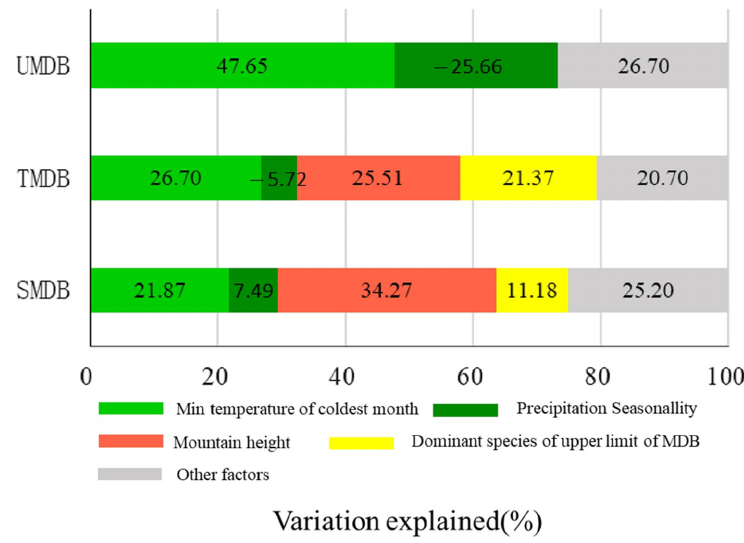
Figure 9. The relative contribution of environmental factors to the geographical pattern of the upper limit of montane deciduous broad-leaved forest in the east realm of China. UMDB, the upper limit of deciduous broad-leaved forest on the mountains with climatic treeline; TMDB, the upper limit of deciduous broad-leaved forest on the temperate mountains without climatic treeline; SMDB, the upper limit of deciduous broad-leaved forest on the subtropical mountains without climatic treeline. “ − ” in front of a number indicates that the independent variable was negatively correlated with the dependent variable; no sign in front of a number indicates that the independent variable was posi- tively correlated with the dependent